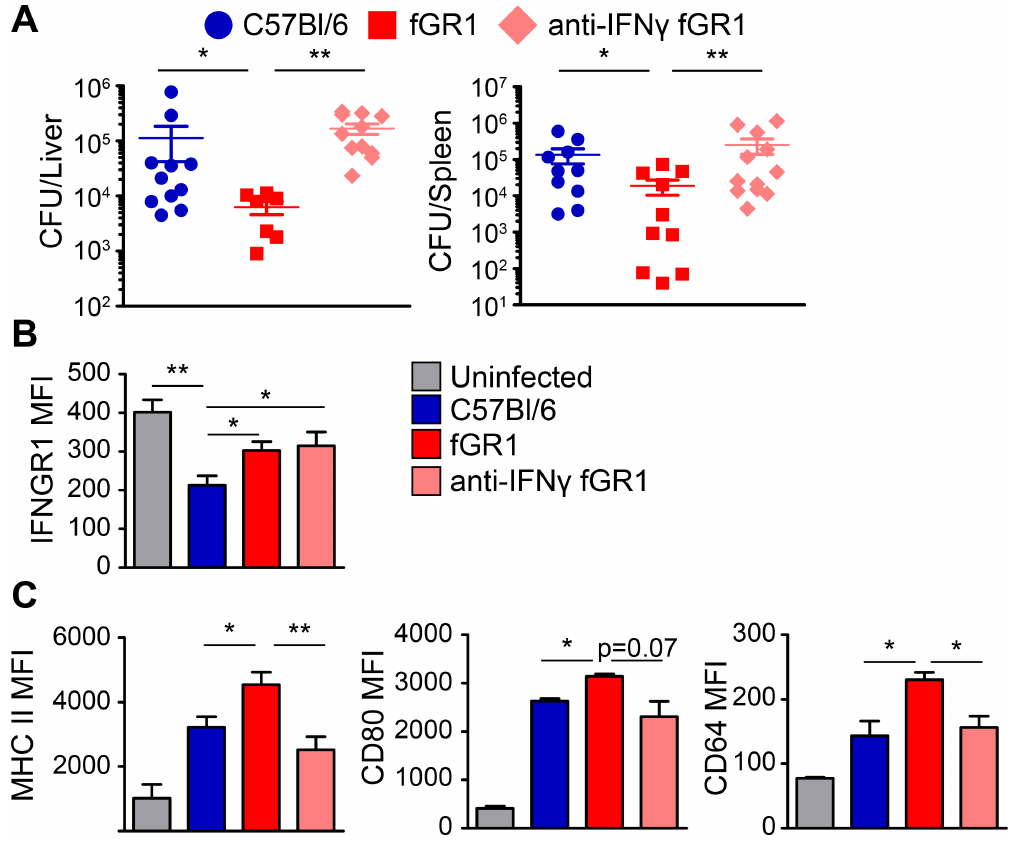
Fig 6. IFN γ is required for increased resistance of fGR1 mice to L . monocytogenes infection. C57Bl/6and fGR1 mice were treated with PBS or 500 μ g of α -IFN γ depletion antibody 24 hrs before infection with a low dose (5 x 10 3 CFUs) of L . monocytogenes . A) Bacterial burdenswere determinedin both the liver and spleen 72 hpi. (Data pooledfrom 3 independentexperiments, 3–5 mice per group, * Mann-Whitney Test). The splenicinflammatory monocytes were analyzedby flow cytometry for the surface expression of B) IFNGR1 and C) pro-inflammatory activation markers MHC II, CD80, and CD64. (MFIs are pooledfrom 2-independent experiments, 3–5 mice per group, * Two-Tailed